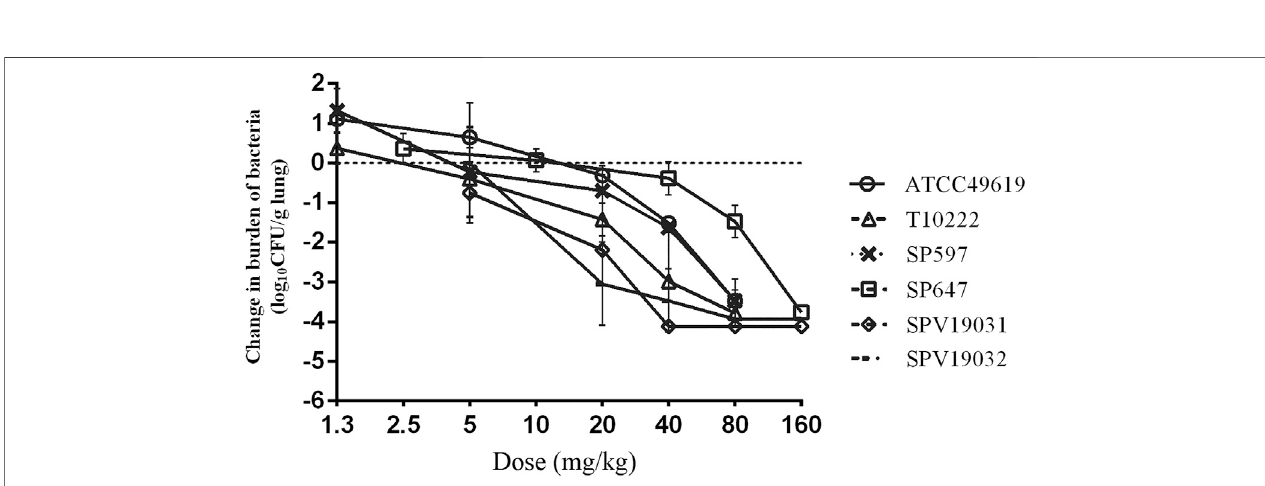
FIGURE 3 | In vivo dose-response curves for nemonoxacin against six Streptococcus pneumoniae strains over a 24 h study period after a single dose administration in the neutropenic murine lung infection model. Each symbol represents the mean and standard deviation from three mice. The burden oforganisms was measured at the start and end of therapy. The horizontal dashed line at 0 represents no net change from baseline.